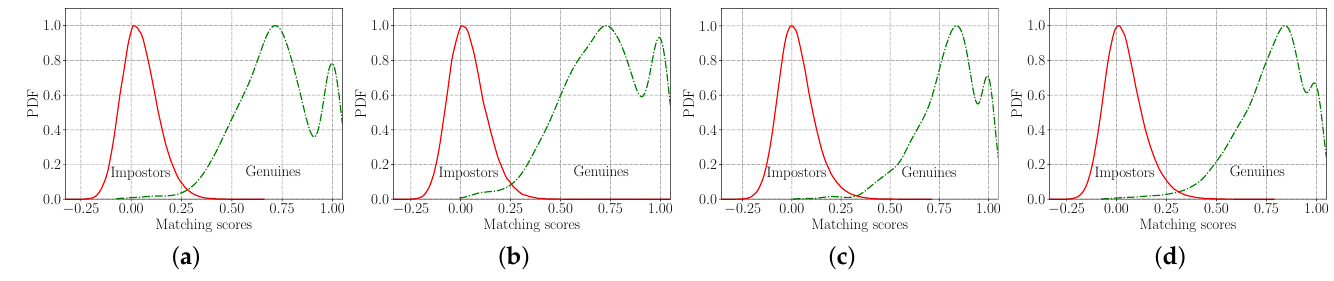
Figure 16. Genuine-impostor score distributions expressed as probability density functions (PDFs) when evaluating on different palmprints: ( a ) IITD left palmprints, ( b ) IITD right palmprints, ( c ) CASIA left palmprints and ( d ) CASIA right